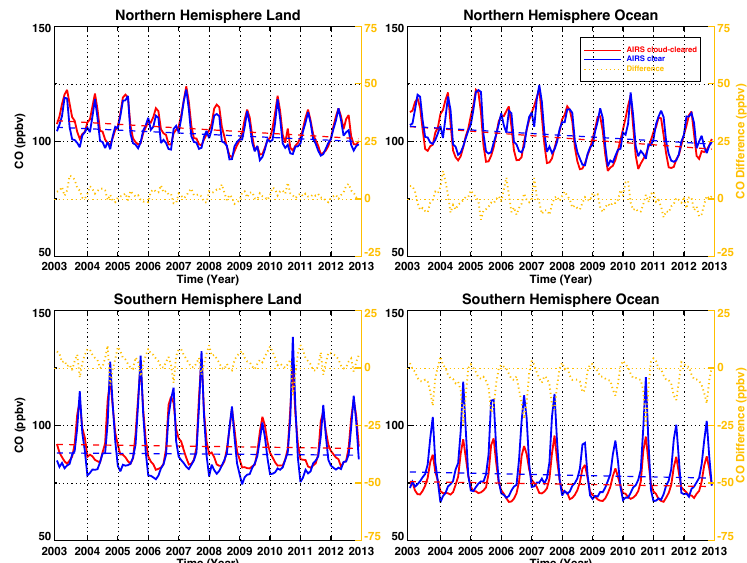
Figure 5b. As Fig. 5a except for nighttime. Fig. 5b. As Fig. 5a except for